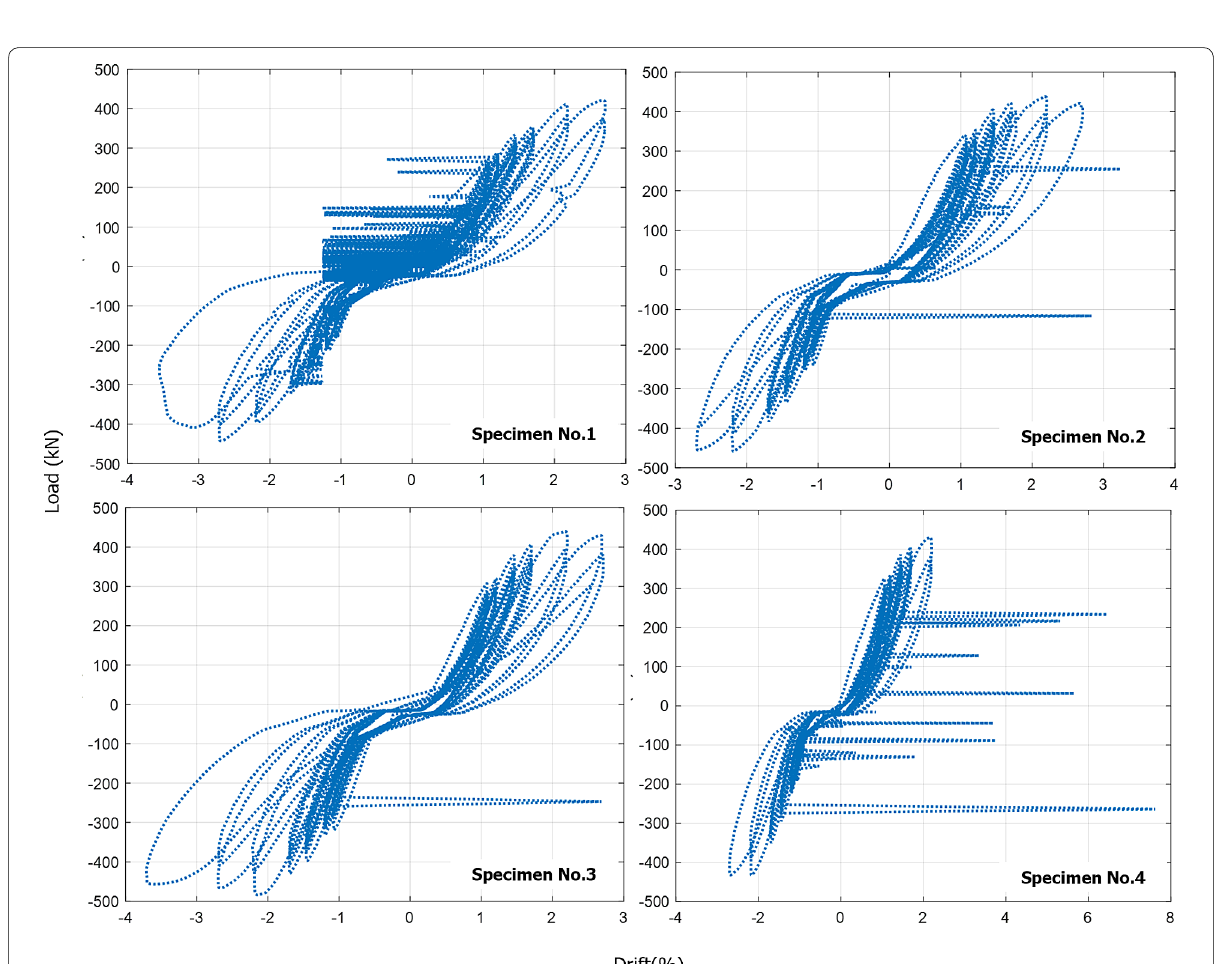
Fig. 15 Original test data contaminated by